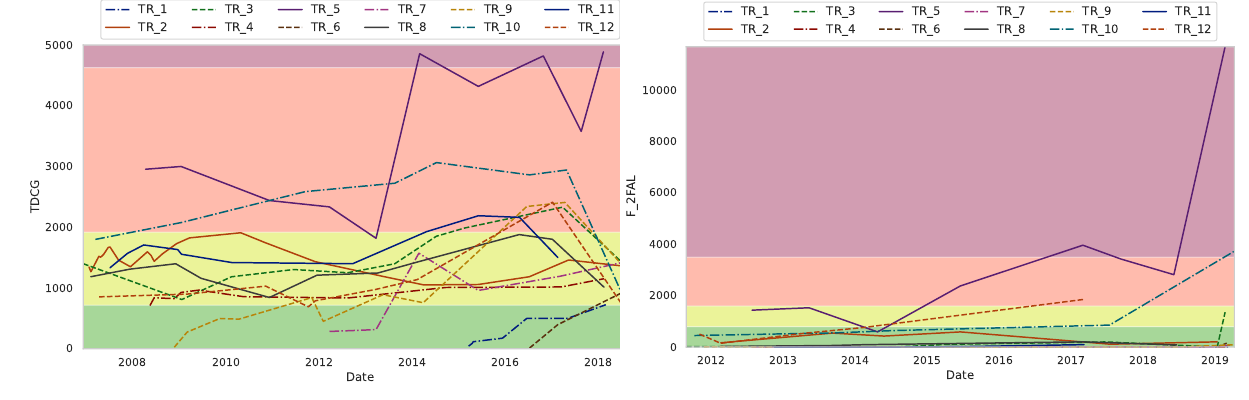
( b ) Records of furan 2FAL in ppm for the 12 power transformers